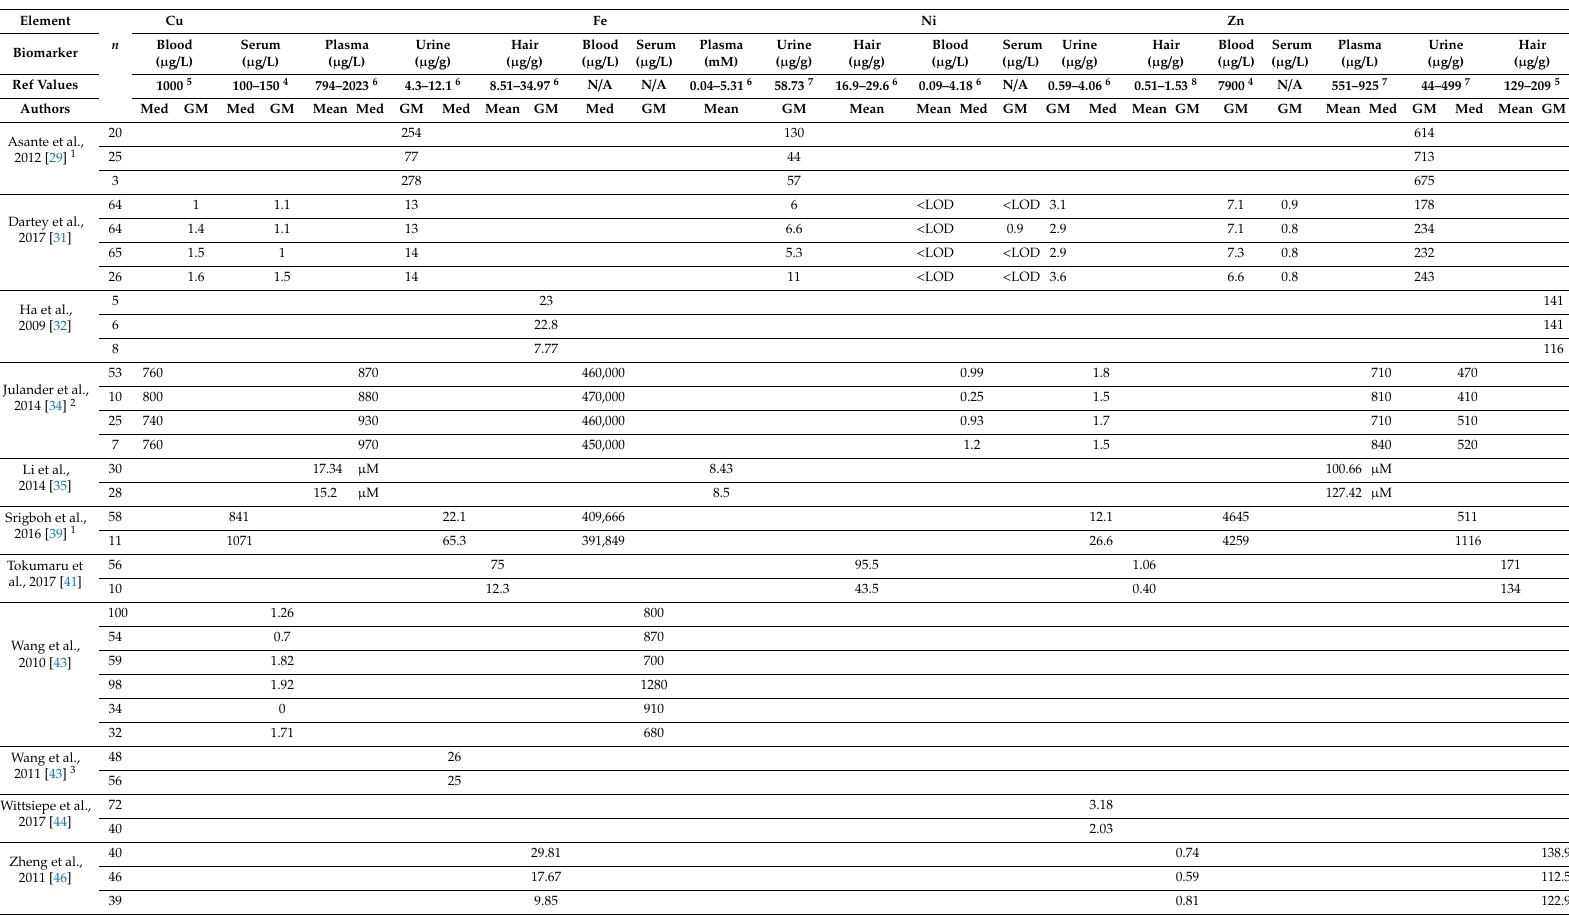
Table 7. Results of data extraction from study set for Cu, Fe, Ni, Zn biomarkers in blood, serum, plasma, urine, and